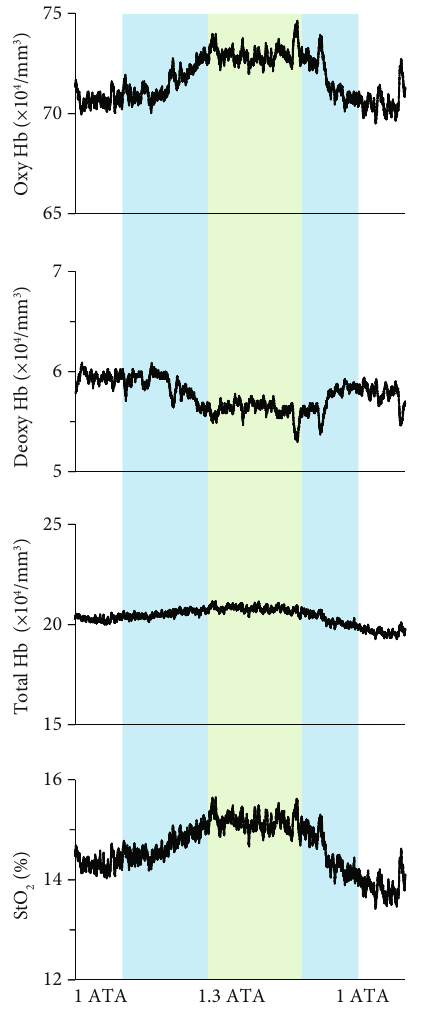
Figure 5: Representative NIRS data for calf muscles during hyperbaric treatment. The green area indicates 1.3ATA, and blue areas indicate early compression and late decompression periods. Each variable was sequentially calculated every